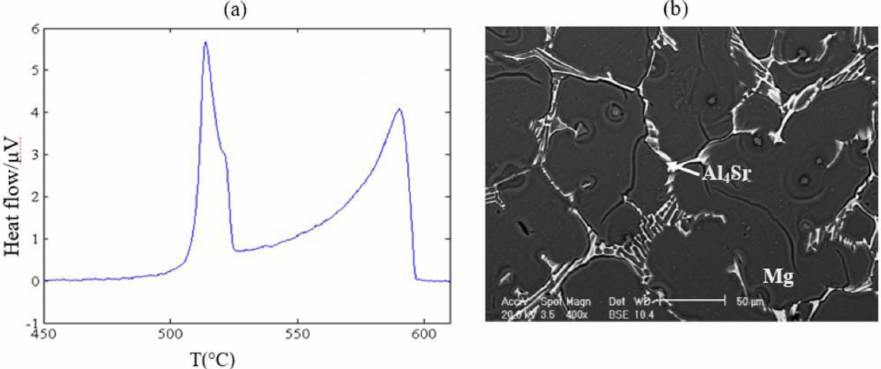
Figure 2. (a) DSC spectra and (b) SEM for sample 1 (3.32/87.29/9.39, Sr/Mg/Al,